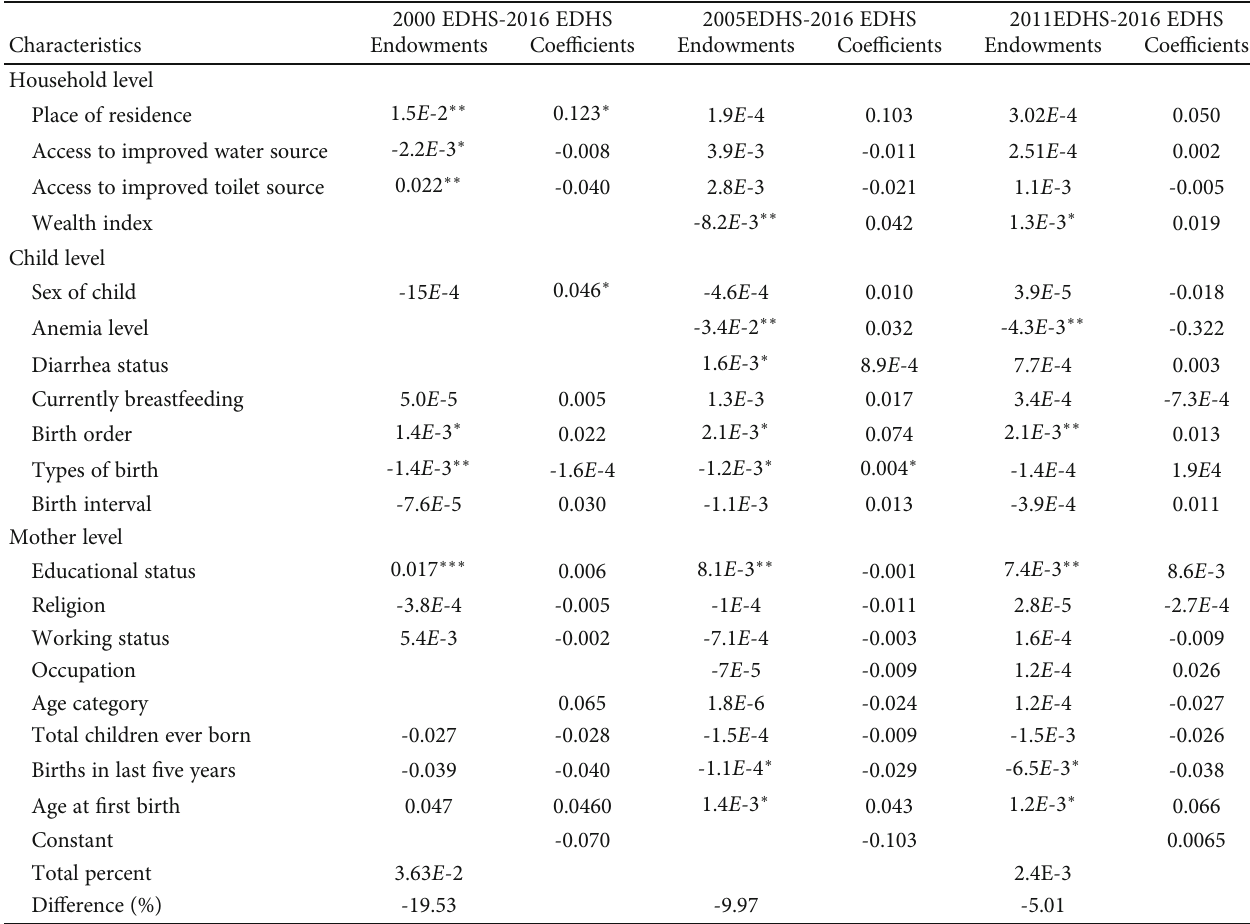
Table 3: Multivariate decomposition of di ff erent characteristics from 2000 to 2016 of